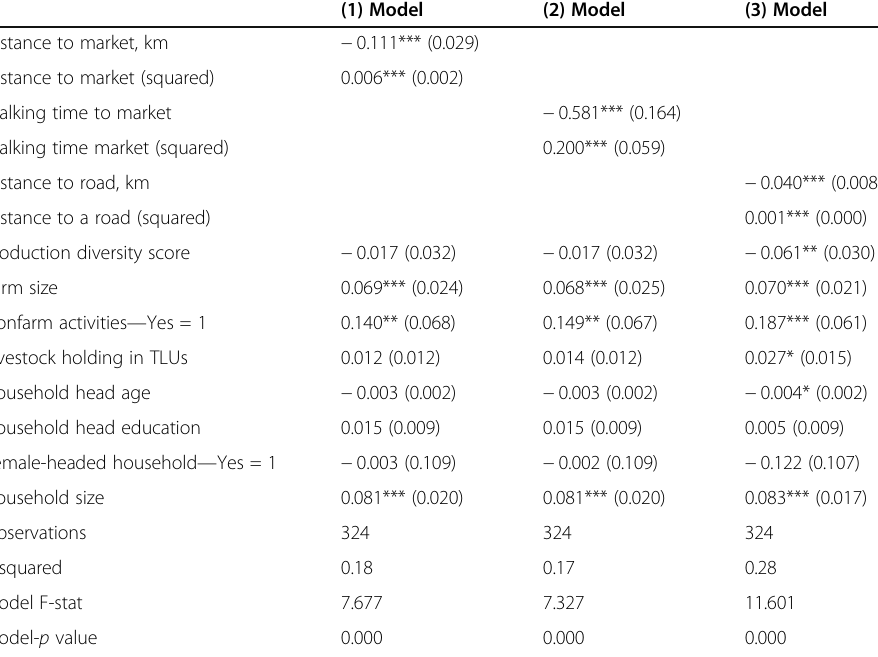
Table 7 Association between household food expenditure and market access for 324 smallholder households (1) Model (2) Model (3) Model Distance to market, km − 0.111*** (0.029) Distance to market (squared) 0.006*** (0.002) Walking time to market − 0.581*** (0.164) Walking time market (squared) 0.200*** (0.059) Distance to road, km − 0.040*** (0.008) Distance to a road (squared) 0.001*** (0.000) Production diversity score